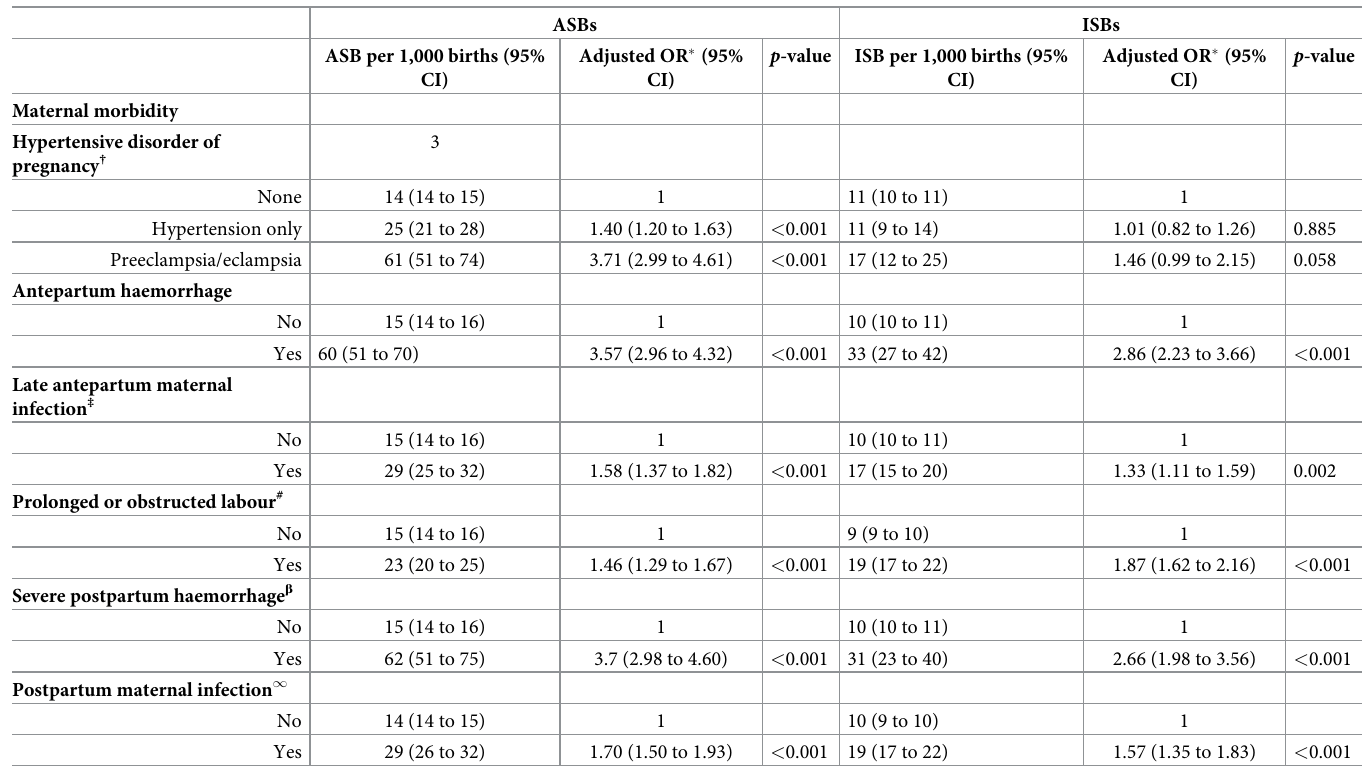
Table 4. Adjusted association of maternal morbidities with ASBs and